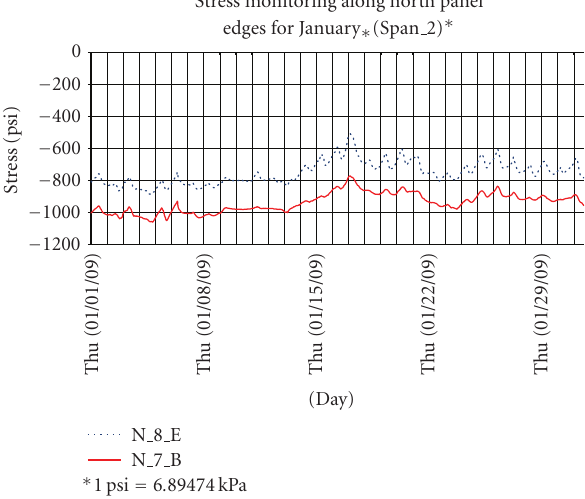
Figure 8: Stress monitoring along north panel edge for span two (January).